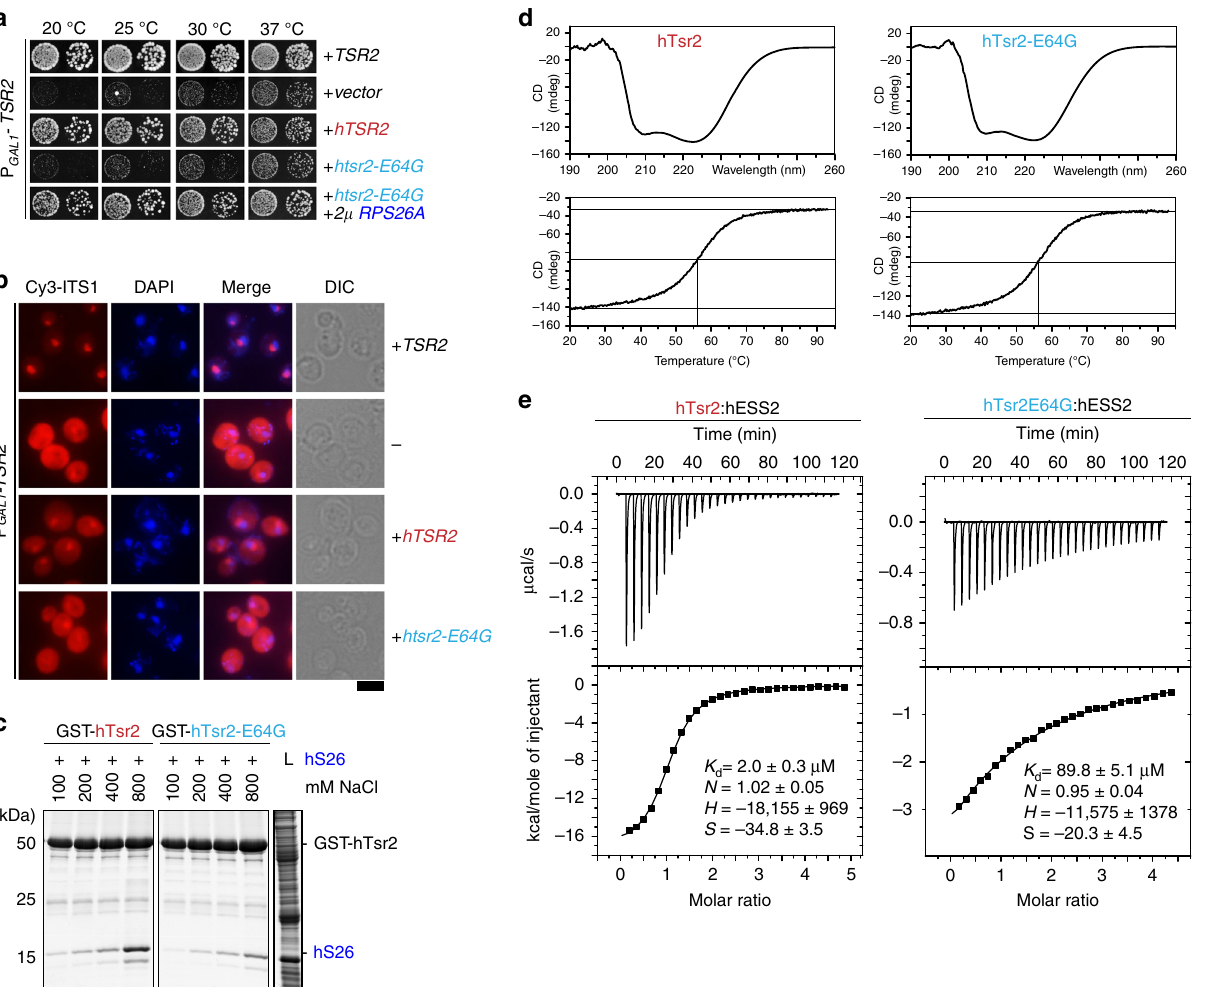
Fig. 5 DBA-linked Tsr2E64G mutant is impaired in binding ESS2. a hTsr2E64G mutant expressed in yeast impairs yeast growth. Overexpression of eS26 rescues from the impaired growth. The conditional P GAL1-TSR2 strain was co-transformed with 2 μ vectors expressing indicated genes. Transformants were spotted in 10-fold dilutions on repressive glucose containing media and grown at indicated temperatures for 2 – 4 days. b Tsr2 DBA mutant cells (hTsr2E64G) accumulate immature 20S pre-rRNA in the cytoplasm. P GAL1 - TSR2 cells were grown at 30 °C in glucose containing media to mid-log phase. Localization of 20S pre-rRNA was analyzed by FISH using a Cy3-labeled oligonucleotide complementary to the 5 ′ portion of ITS1 (red). Nuclear and mitochondrial DNA was stained with DAPI (blue). Scale bar = 5 µ m. c hTsr2E64G mutant inef fi ciently binds eS26. GST-hTsr2 and GST-hTsr2E64G were immobilized on Glutathione Sepharose before incubation with E. coli lysate containing recombinant eS26 and incubated at indicated salt concentrations. Bound proteins were eluted by SDS sample buffer, separated by SDS-PAGE, visualized by Coomassie Blue staining. L = input (1:10 diluted). The error bars show the standard deviation. d The far-UV CD spectra of both human WT Tsr2 and the E64G-DBA variant. The midpoints of the thermal denaturation curves followed at 222 nm are at 57 °C for both proteins. e Isothermal titration calorimetry (ITC) measurements of human Tsr2 with human ESS2. The binding isotherms were plotted against the molar ratio. The measured parameters and K d values are indicated within the